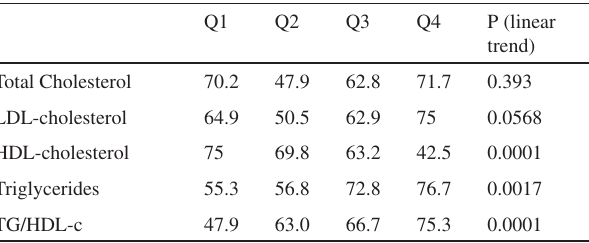
Table 2 - Frequency of extensive coronary disease